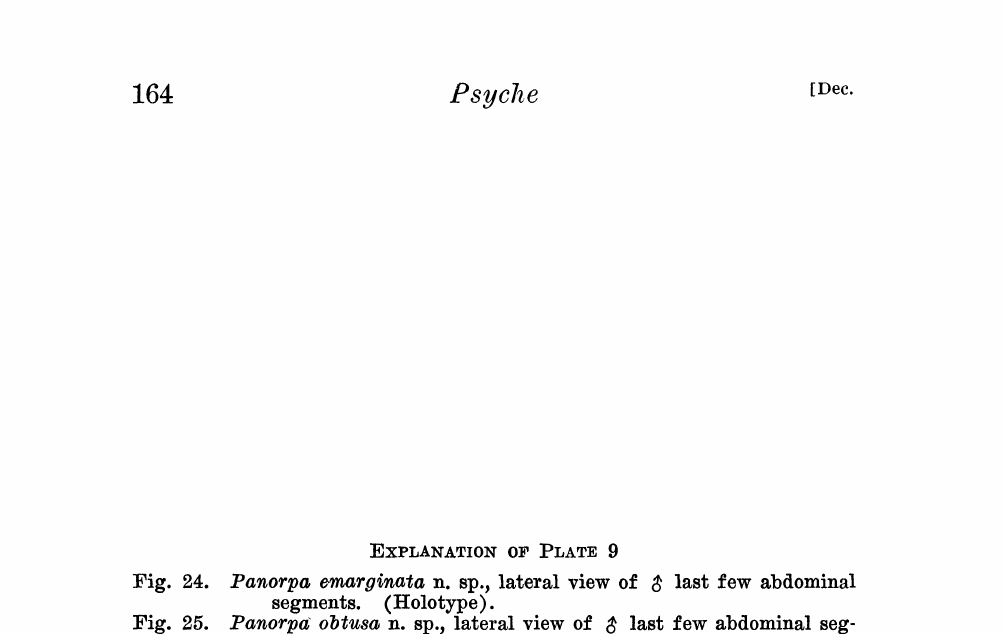
]XPLANATION OF PLATE 9 Panorpa emarginata n. sp., lateral view of 3 last few abdominal segments. (Holotype). Panorpa obtusa n. sp., lateral view of last few abdominal seg- ments. (Holotype). Panorpa emarginata n. sp., ventral view of 3 genital bulb. (Holo- type). Panorpa obtusa n. sp., ventral view of $ genital bulb. (Holo- type). Panorpa typicoides n. sp., ventral view of genital bulb. (Holo- type). Panorpa emarginata n. sp., ventral view of genital bulb, show- ing mdeagus. (Holotype). Panorpa obtusa n. sp., ventral view of $ genital bulb, showing mdeagus. (Holotype). Panorpa typicoides n. sp., ventral view of 3 genital bulb, showing Fig. 31. mdeagus.